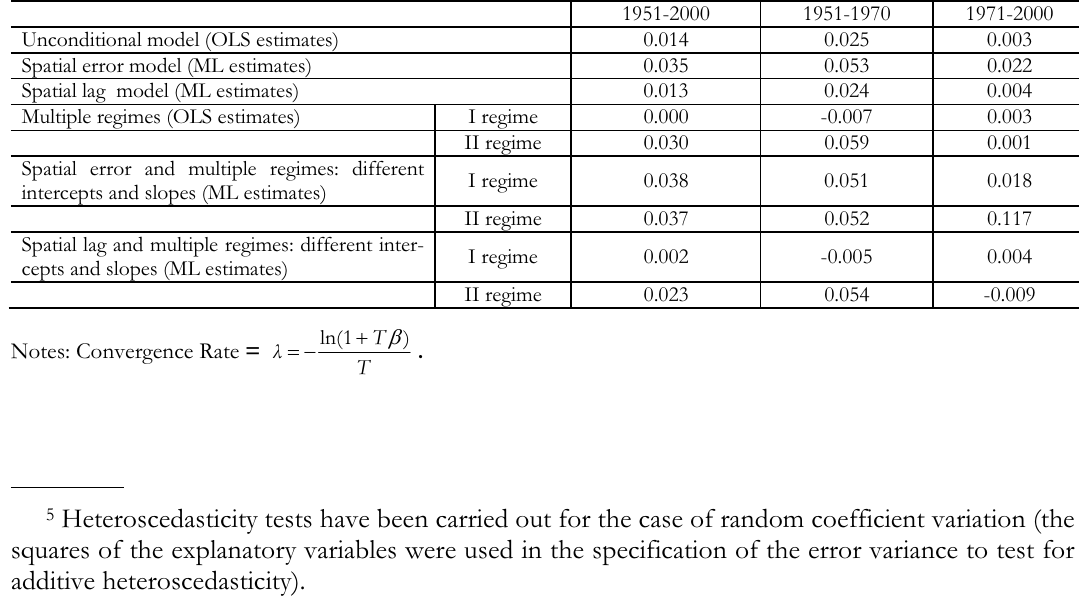
Comparison of the Convergence Rates Estimated with the Different